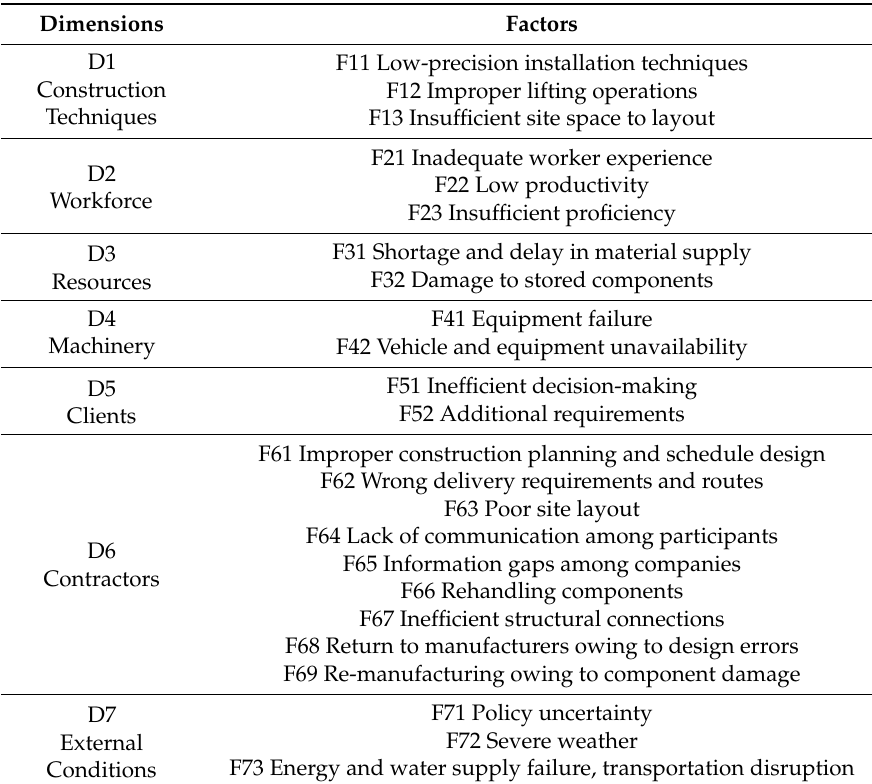
Table 2. Key factors affecting project progress in prefabricated building